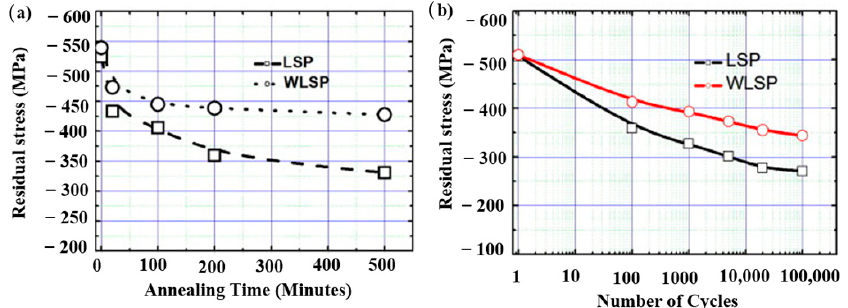
Figure 18. Comparison of WLSP and LSP on AISI 4140 steel ( a ) stress relaxation at 300 ◦ C; ( b ) stress relaxation after cyclic loading. Reproduced with permission from [131]. Copyright Elsevier,